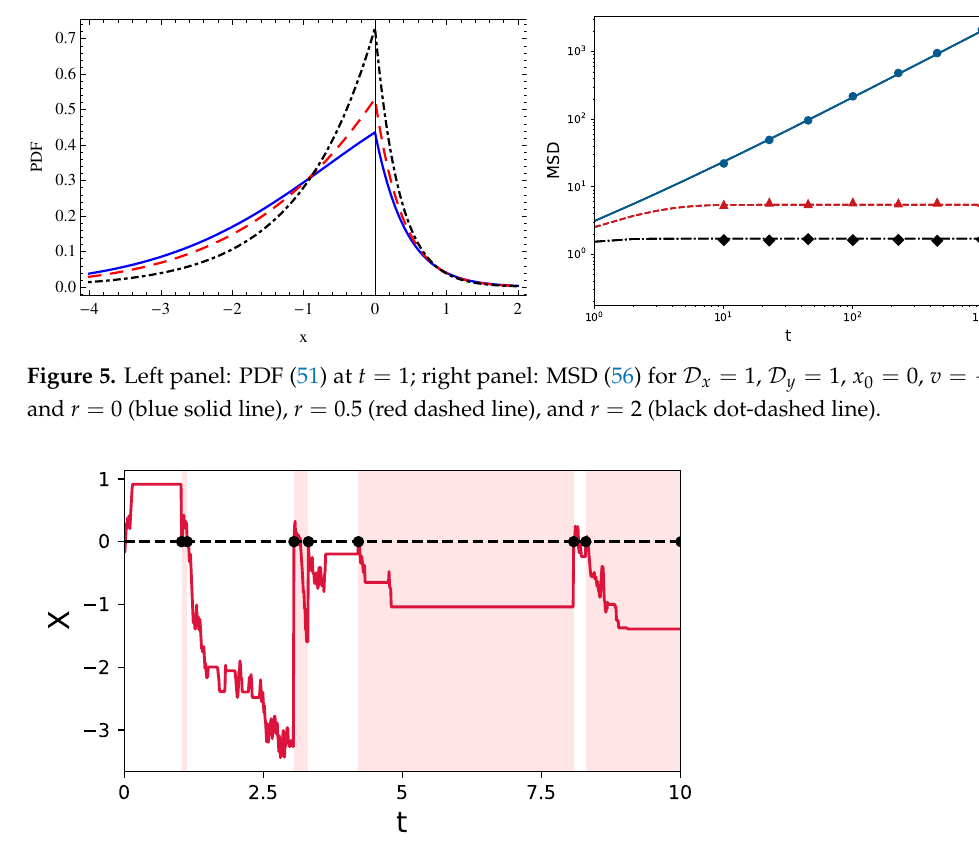
Figure 6. A typical trajectory of particles in the presence of stochastic resetting to the initial position ( x ) = ( 0,0 ) for r = 0.5, D x = 1, D y = 1, and v = − 2. The resetting events are represented by 0 , y 0 black dots. Dashed regions are introduced for these resetting events to be more visible.